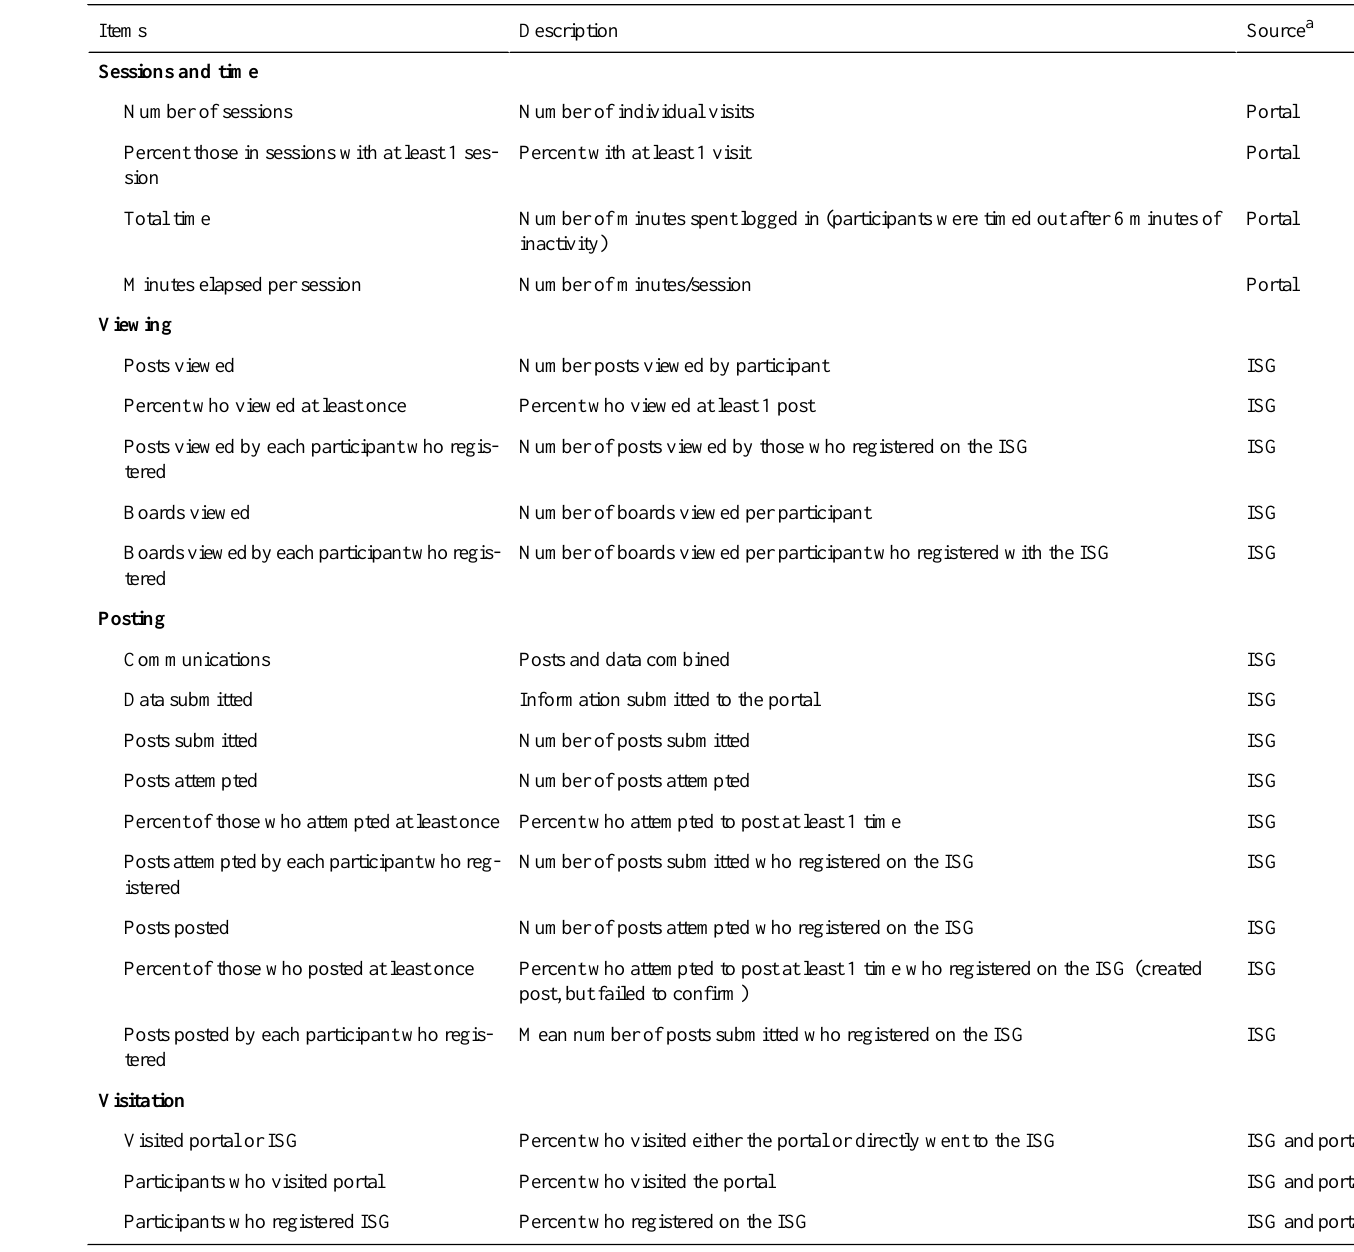
Table 1. Outcome